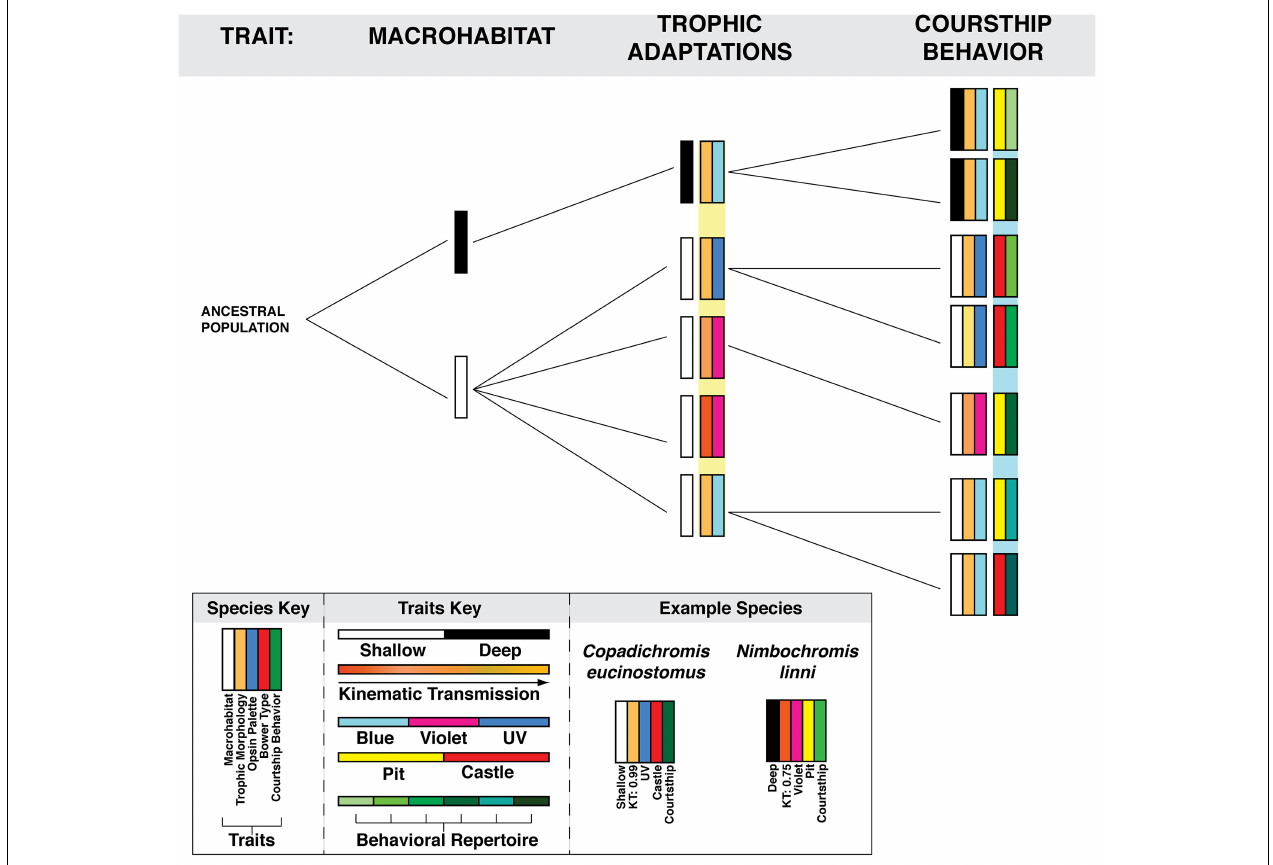
FIGURE 6 | The segregation of traits within the bower-building cichlid adaptive radiation. Each column represents a trait upon which bower-building species may differentiate. The resulting rectangles represent individual species and the combination of traits each possesses. Variation in multiple traits may interact to constrain possible behavioral outcomes such as bower type and species-specific courtship behavior. An example of this is the association between trophic jaw morphology, opsin palette, and foraging preference. Variation within these traits may influence